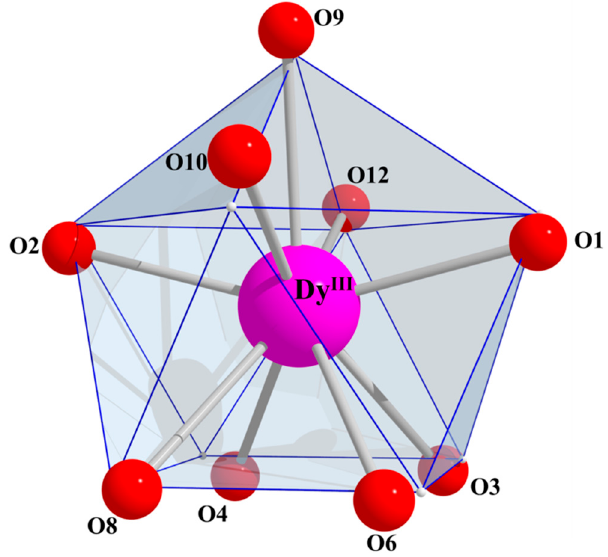
Figure 6. The spherical capped square anti-prismatic coordination polyhedron of the Dy III center in complex 18 _Dy. The smaller cream spheres define the vertices of the ideal polyhedron.